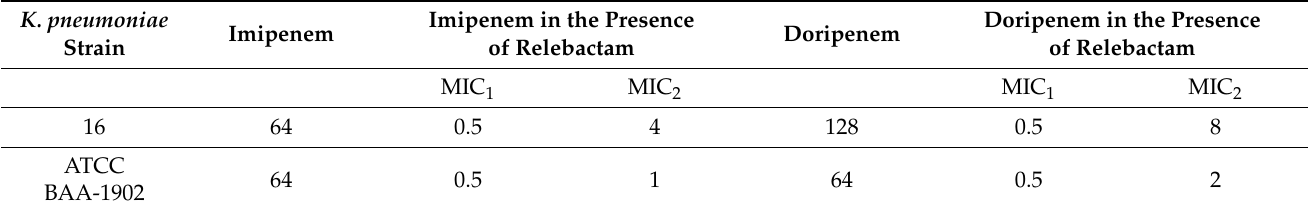
Table 1. MICs (mg/L) of imipenem and doripenem, alone or in the presence of relebactam against K. pneumoniae . K.